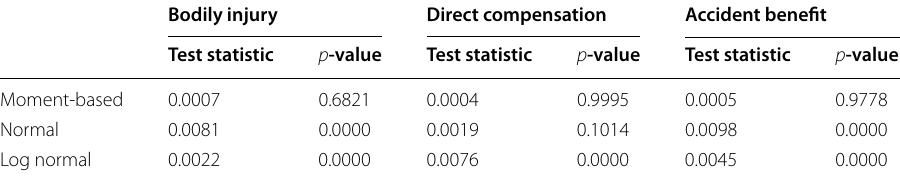
Table 11 Results of the KS test under different methods Bodily injury Test statistic p -value Test statistic p